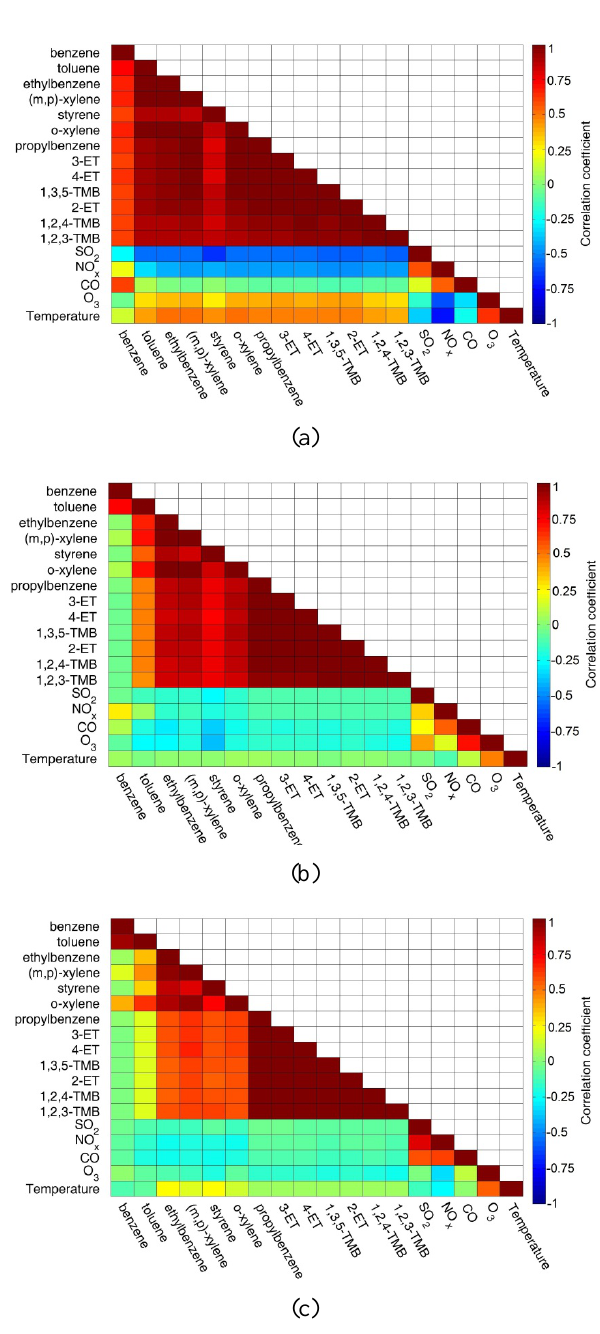
Figure 7. Correlation analysis for aromatic hydrocarbons with one another and with inorganic trace gases in samples that were collected when back trajectory sets had passed over area I (a) , area II (b) and the regional background (c).